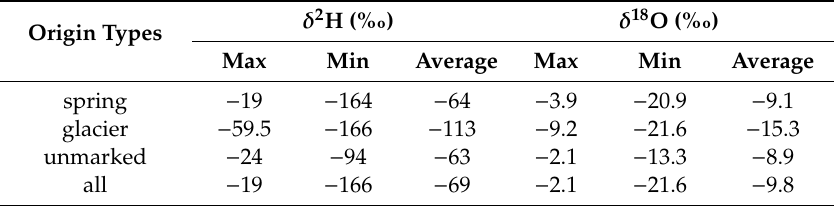
Table 1. Descriptive characteristics of bottled water stable isotope